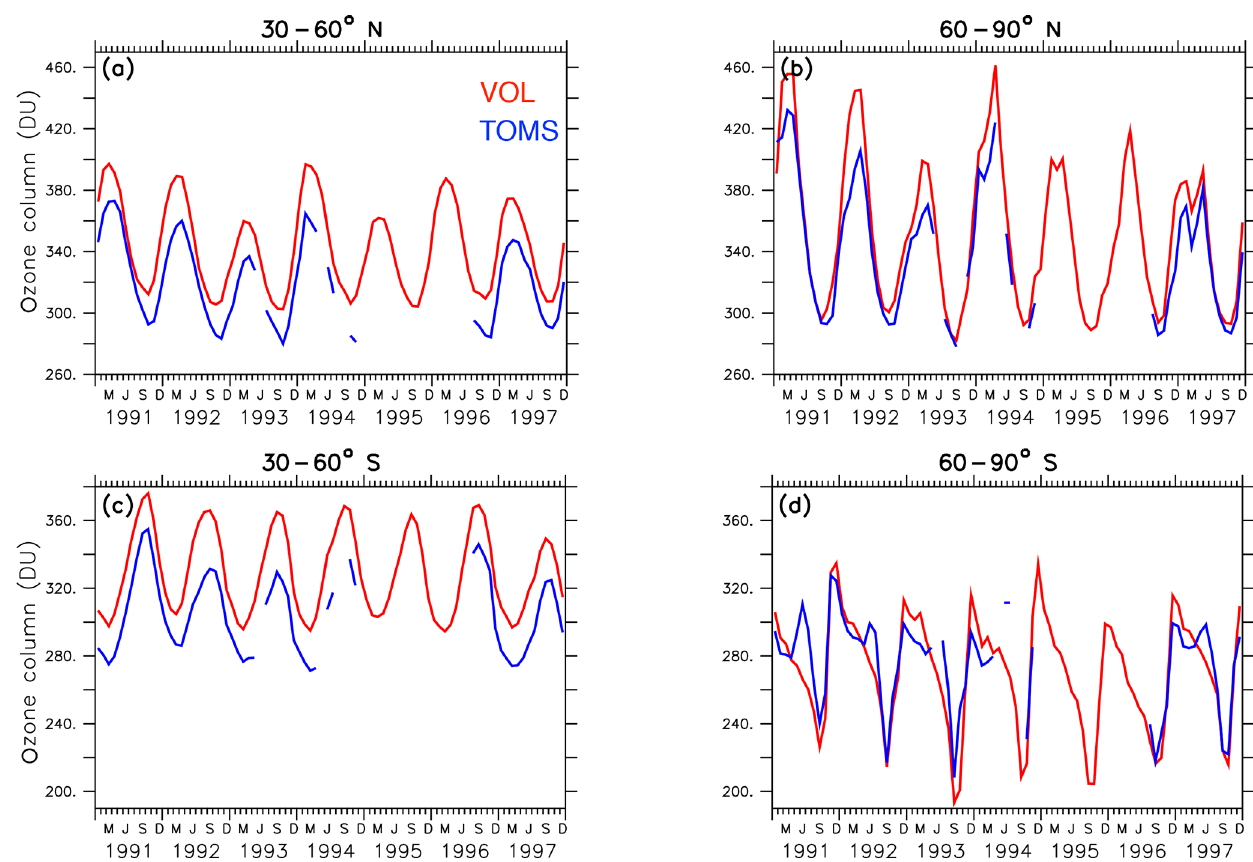
Figure 4. Lines show the zonally and monthly averaged total ozone column (DU) between 30–60 ◦ N (a) and 60–90 ◦ N (b) as well as between 30–60 ◦ S (c) and 60–90 ◦ S (d) of the volcanic simulation VOL and the TOMS data for the period from 1991 to 1997 (TOMS-Science-Team, 2004). The period between 1994 and 1996 shows data gaps because the atmosphere was too opaque for reliable ozone